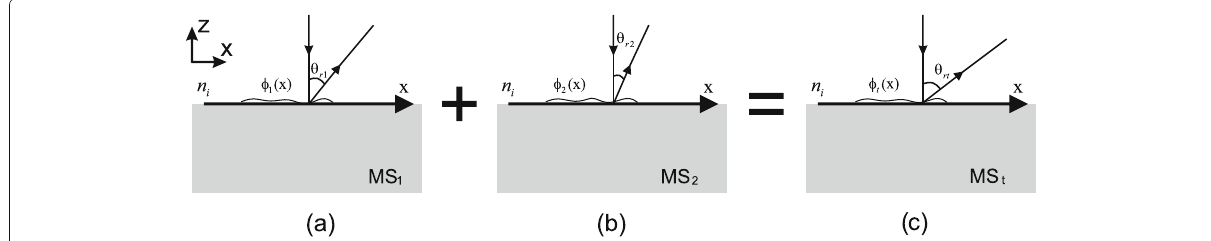
Fig. 5 Illustration of combining two metasurfaces into one multifunctional metasurface. In the inset, the electromagnetic waves are impinging normally from upper space with refractive index n i . a Metasruface 1 ( MS 1 ) with phase discontinuity φ 1 ( x ) and b metasurface 2 ( MS 2 ) with phase discontinuity φ 2 ( x ) are combined into c the desired multifunctional metasurface ( MS t ) with phase discontinuity φ t ( x ) . θ r 1 ( x ) , θ r 2 ( x ) and θ rt ( x ) are the angles of anomalous reflection along the interfaces of the metasurfaces, respectively, and the relationship θ rt ( x ) = θ r 1 ( x ) + θ r 2 ( x ) holds everywhere in MS t